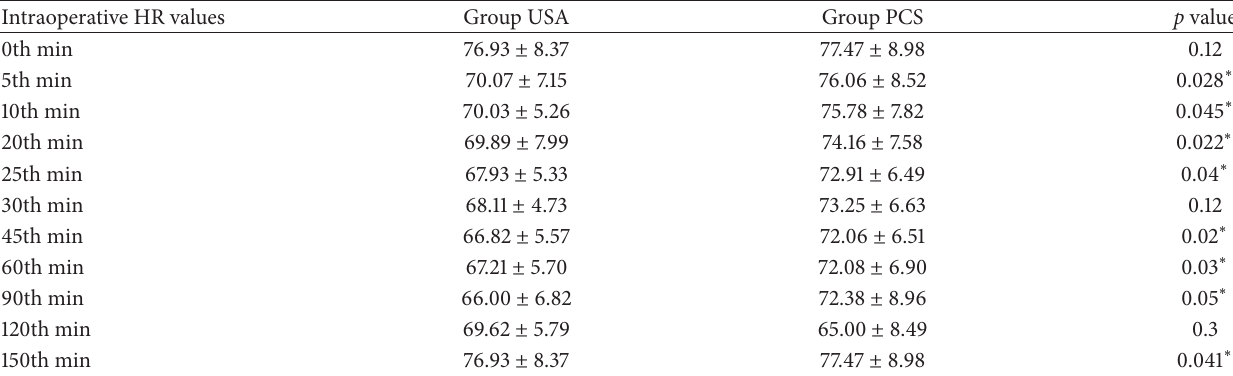
Table 3: Intraoperative heart rate (HR) changes. In between-groups comparisons; ∗ 𝑝 < 0.05 .